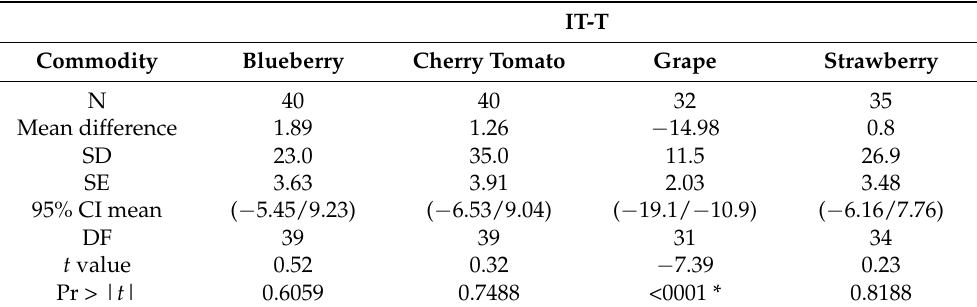
Figure 5. Boxplot represents the texture (IT-T). The dots represent outliers. Table 4. Paired t -test comparing acceptability of texture (IT-T) between the images and real produce based on each